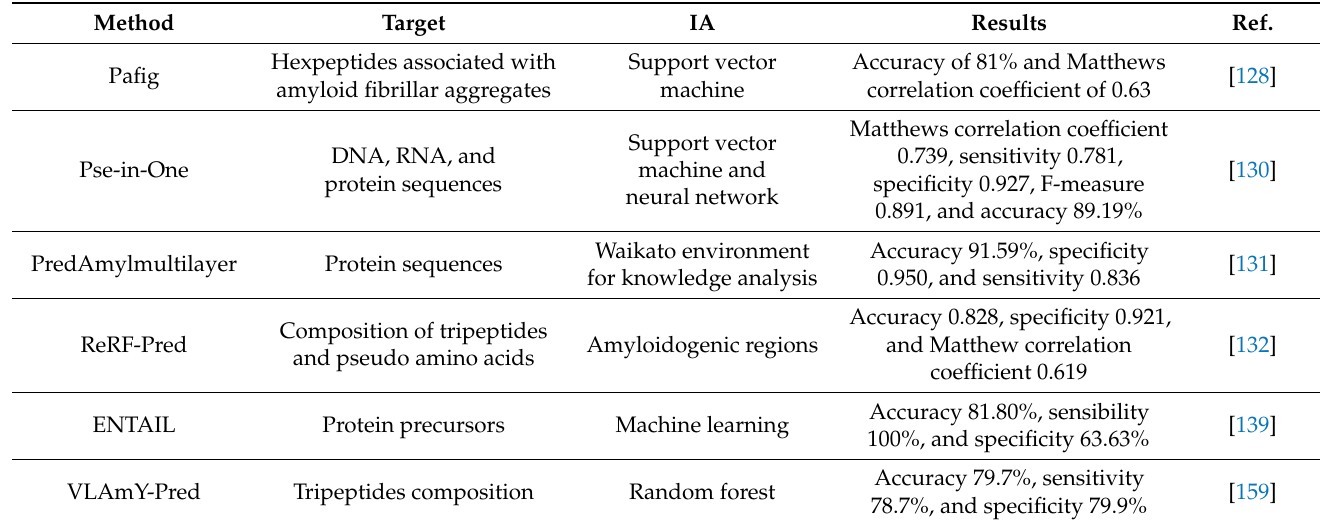
Table 3. Computational methods for amyloid fibril